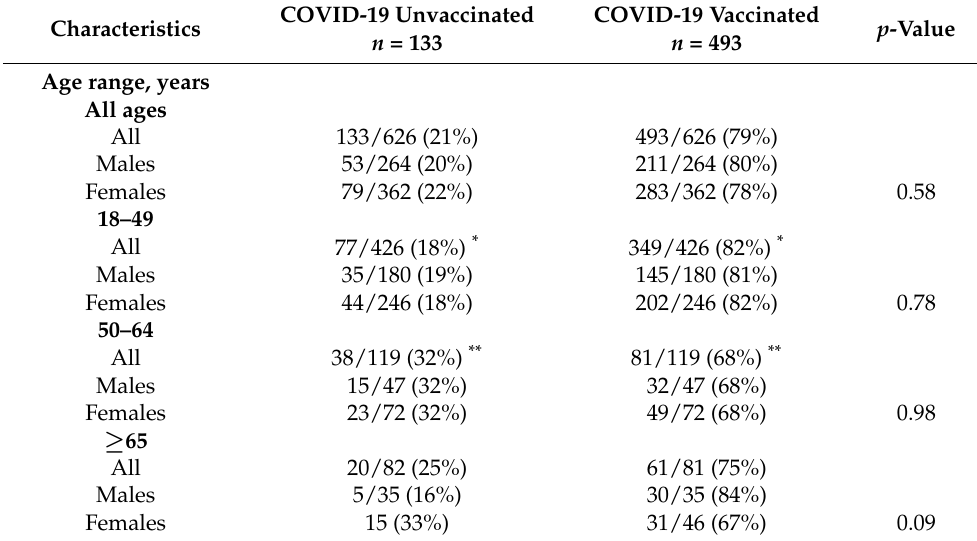
Table 2. COVID-19 vaccination coverage by sex and age